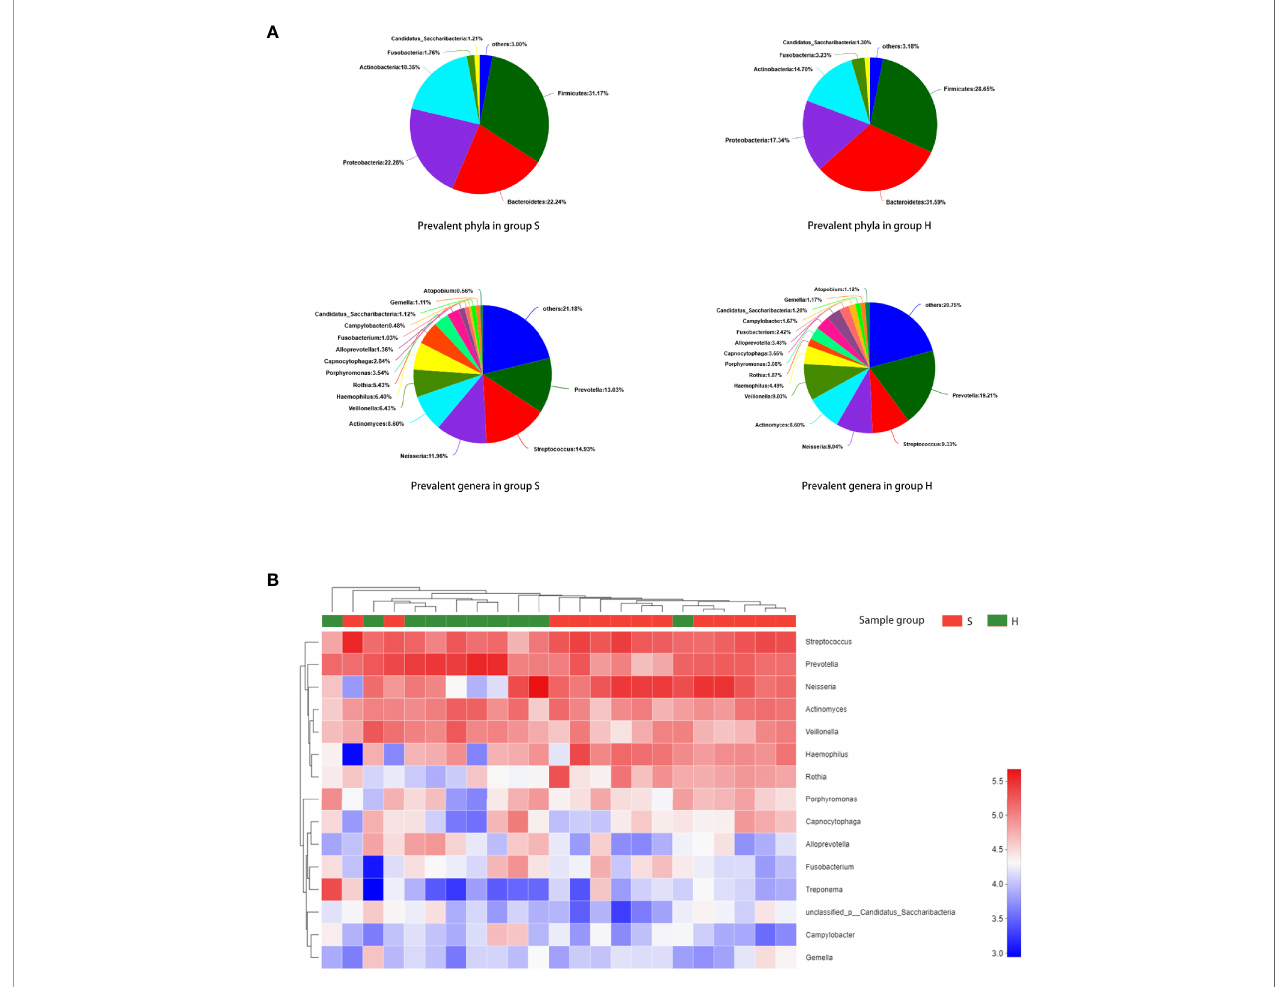
FIGURE 2 | Taxonomic composition of the salivary microbiome. (A) The predominant taxa (relative abundance >1% on average) in each group are shown. (B) Heatmap analysis. Each column represents a sample and each row represents a genus. The cluster trees of genera and samples are shown on the left and upper sides respectively. Different colors represent different relative